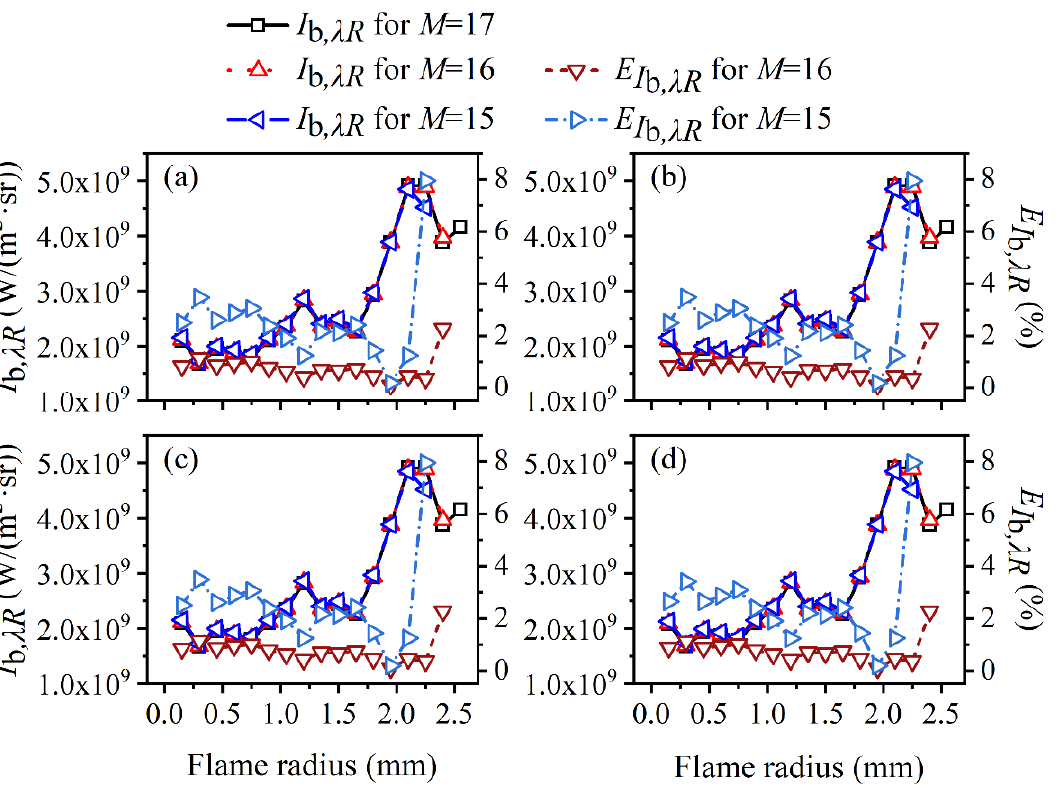
Figure 10. The influence of edge effect on local blackbody radiation intensity using red wavelength under different cases of SNR . ( a ) SNR = 80 dB; ( b ) SNR = 65 dB; ( c ) SNR = 60 dB; ( d ) SNR = 46 dB.